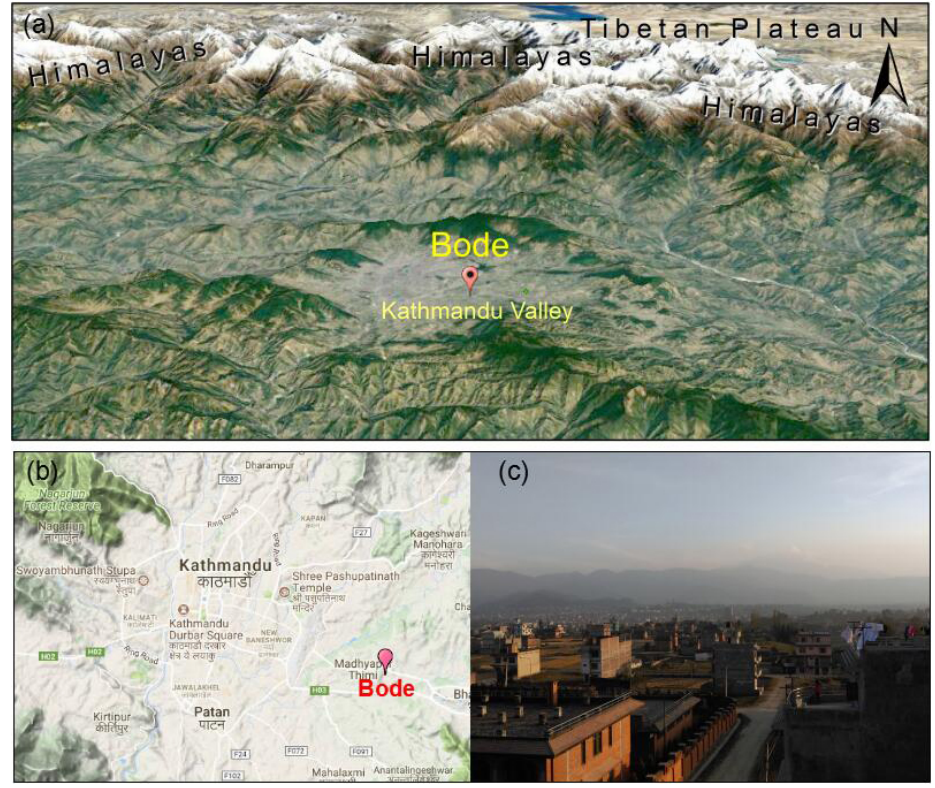
Figure 1. Location of measurement site: (a) Kathmandu Valley, (b) urban measurement site at Bode in the Kathmandu Valley, (c) air pollution observed from the Bode site in the